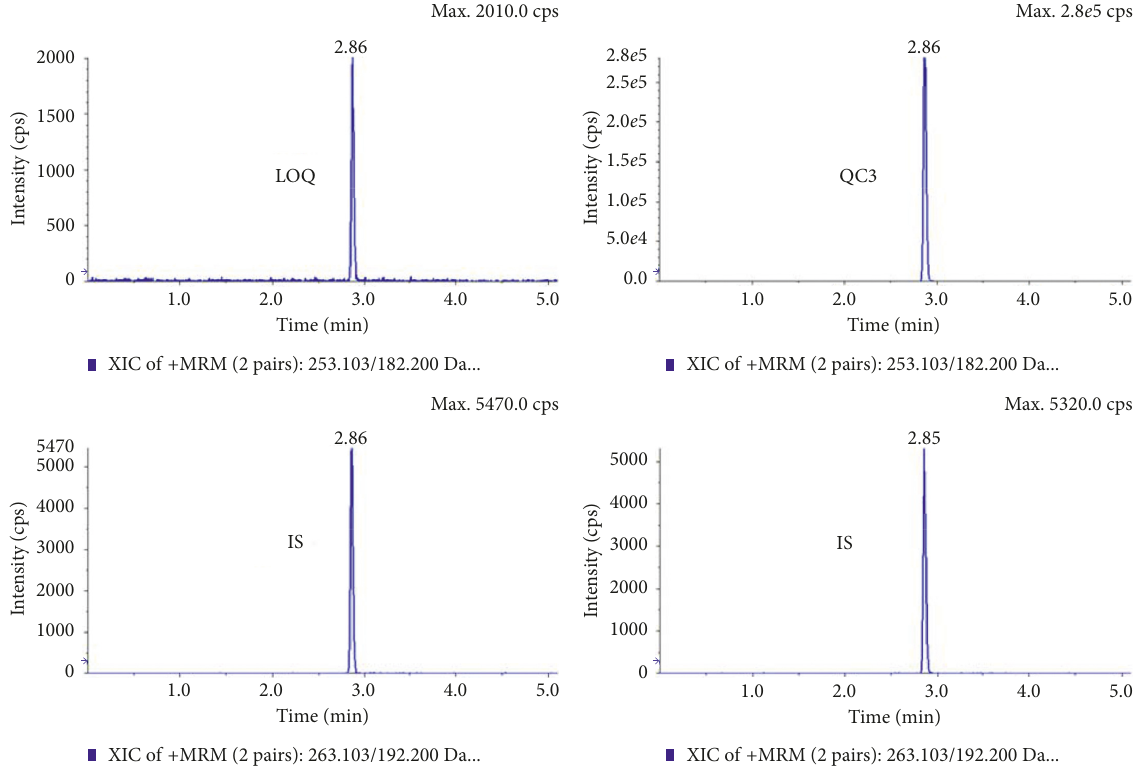
10 as IS (50 ng/mL).